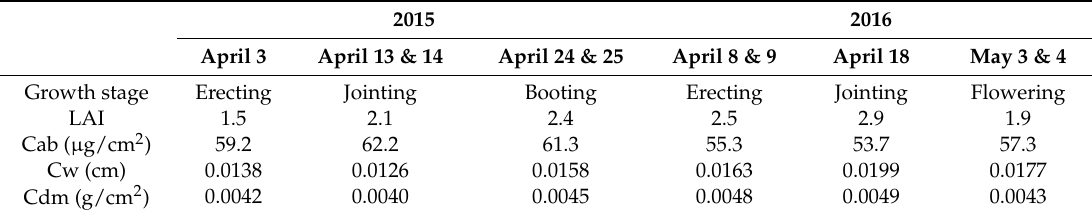
Table 2. The growth stages and vegetation parameters of winter wheat at the time of ten diurnal experiments in 2015 and